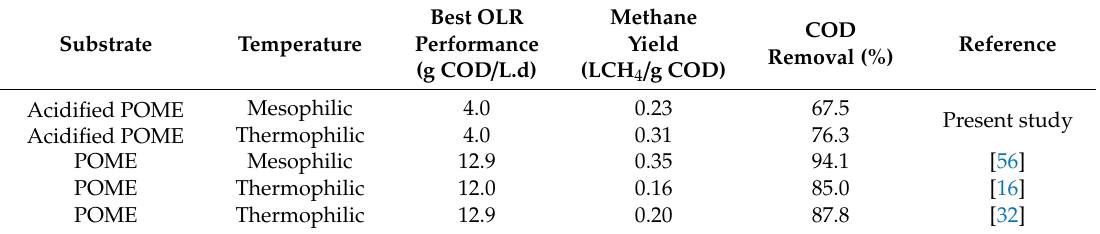
Table 3. Comparison of previous studies on the anaerobic digestion of methane from POME based on di ff erent OLR.